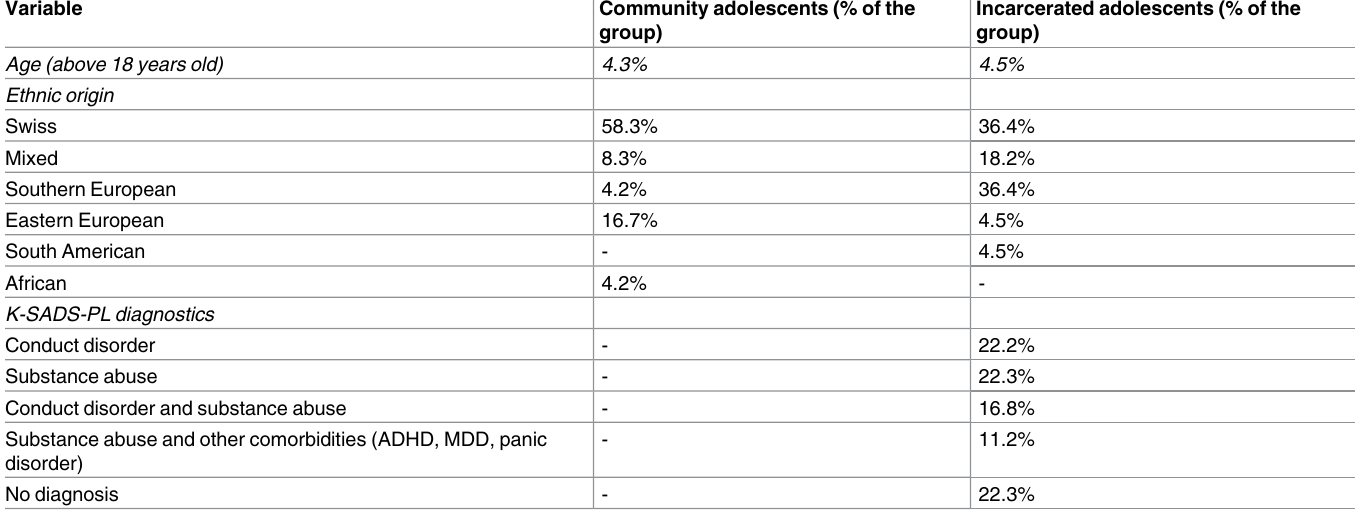
Table 1. Demographic and diagnostic information of the